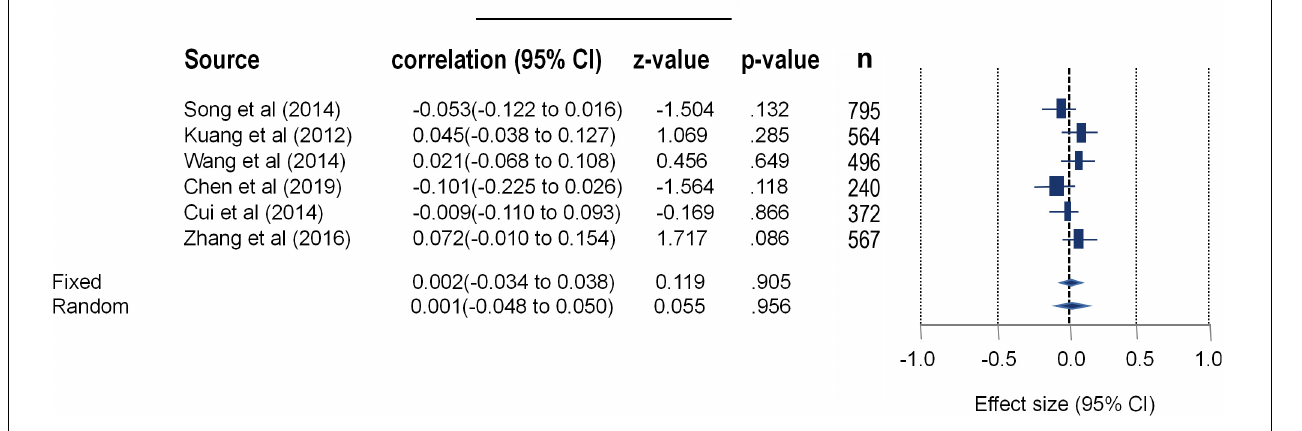
for SES; r = 0.002, p = 0.97 for multi-cultural